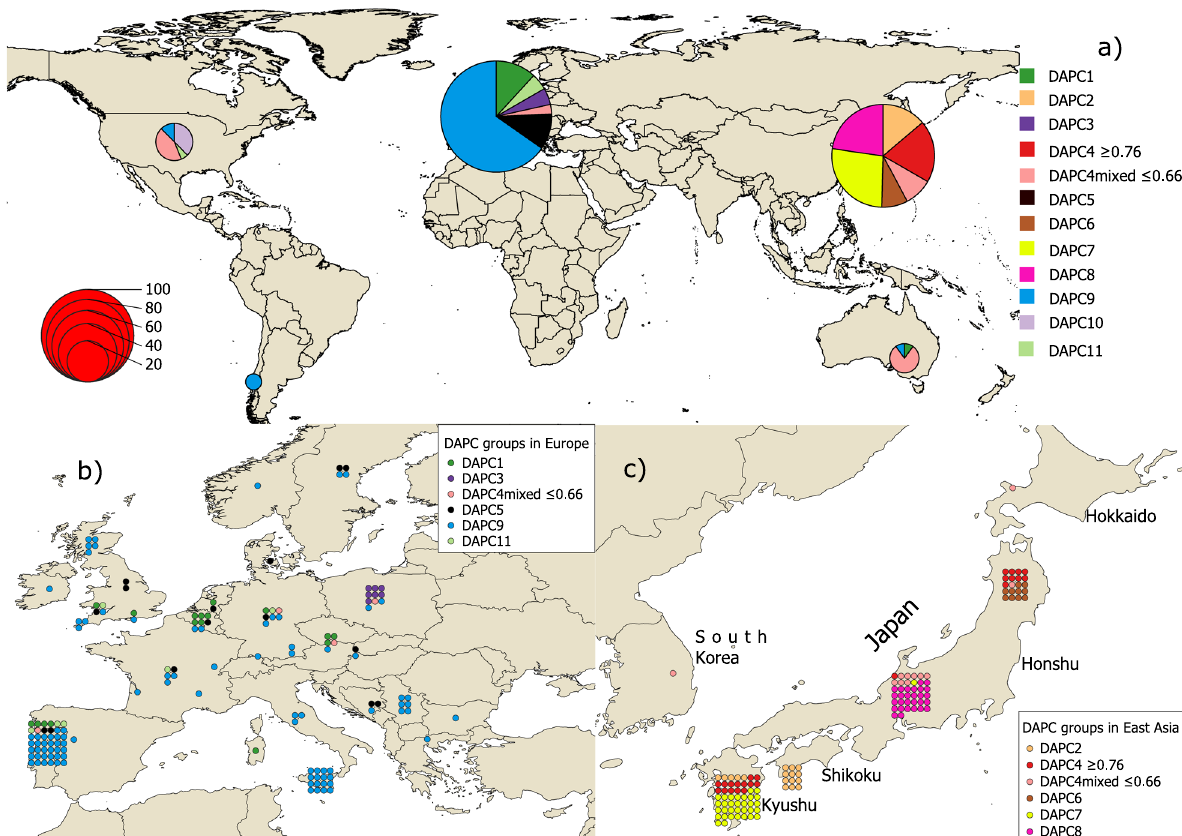
Fig. 2 Distribution maps of P. cambivora isolates and their DAPC groups. a Global overview with pie charts coloured by DAPC group. Size of × pie chart corresponds to the number of isolates. b European sampling locations with each isolate represented by a dot coloured by its DAPC group. c East Asian sampling locations with each isolate represented by a dot coloured by its DAPC group. Multiple isolates from the same site are represented as a grid of dots centred on the sampling